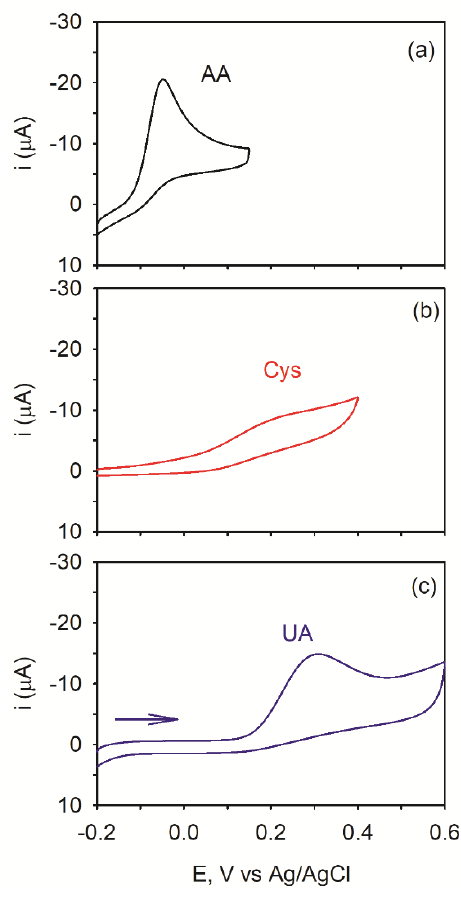
Figure 4. CVs acquired at a separate NPG electrode in a solution containing either ( a ) 0.5 mM ascorbic acid (AA), ( b ) Cysteine (Cys), and ( c ) uric acid (UA) in pH 7.4, 0.1 M PB). Scan rate: 50 mV/s.